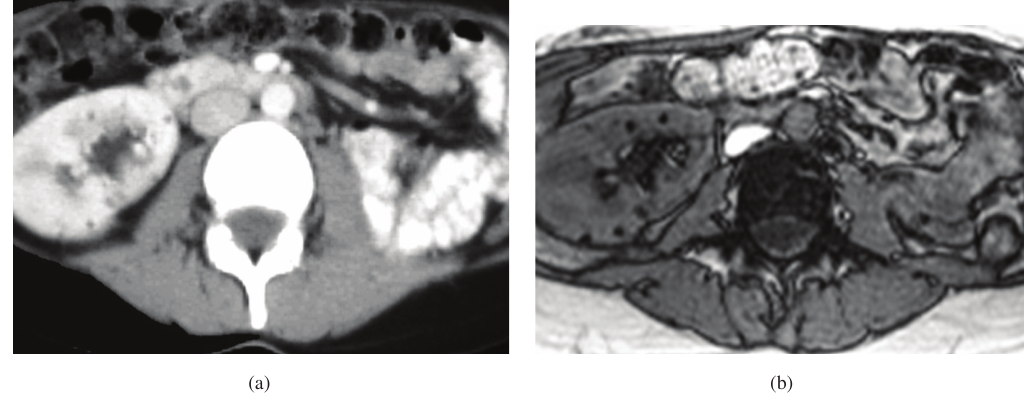
FIGURE 4: (a) Axial CT appearance of the right kidney after a 12-month treatment with low-dose rapamycin. (b) Axial MRI appearance of the right kidney after a 12-month treatment with low-dose rapamycin. No angiomyolipomas regrowth was apparent. Only small intraparenchymatous cystic lesions less than 14 mm were